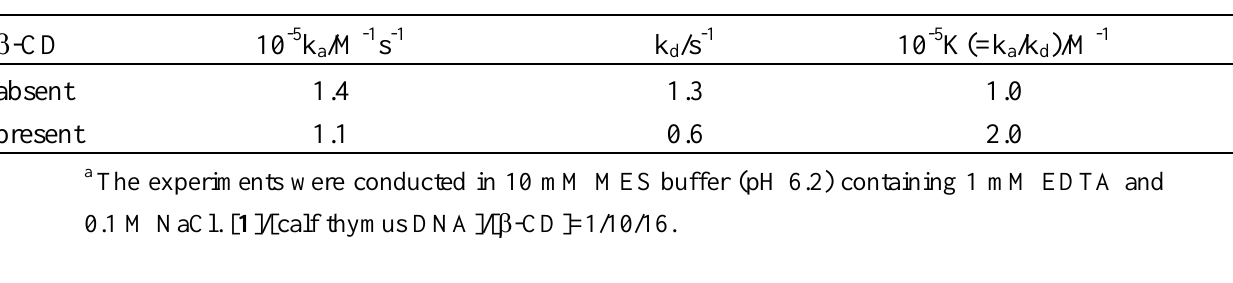
Table 1 Kinetic parameters of the binding of 1 to sonicated calf thymus DNA in the absence or presence of β -CD a